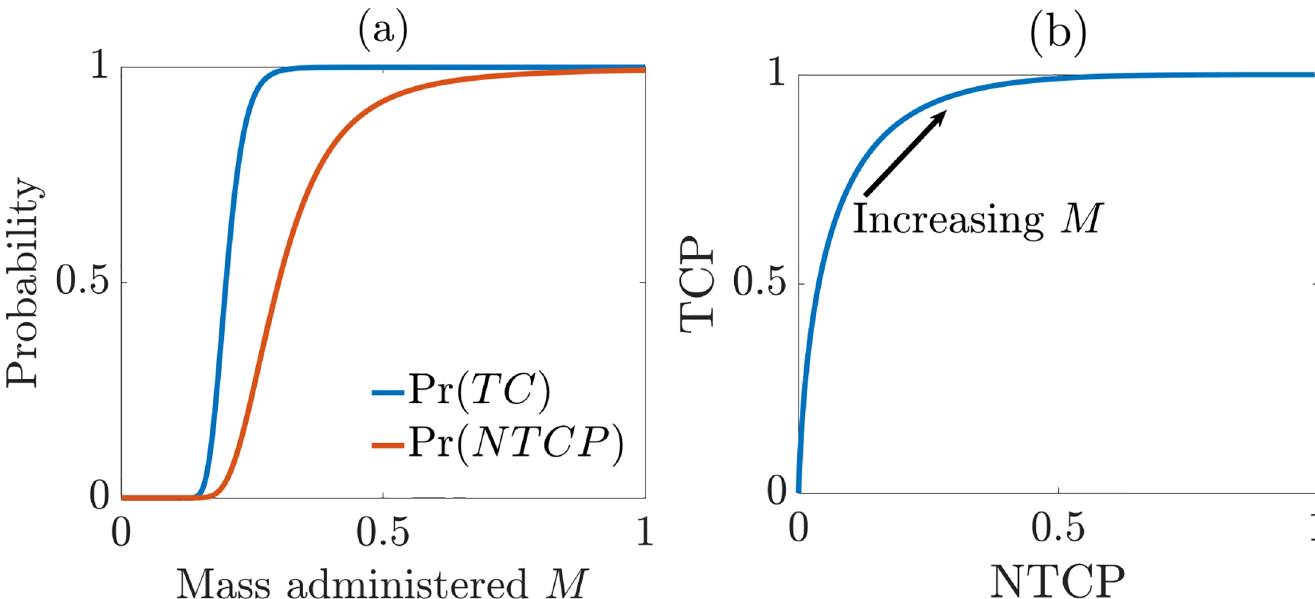
Fig 6. TOC curves. An illustration of a Therapy Operating Characteristic (TOC) curve. (a) Schematic plot of Tumor-Control Probability (TCP) and Normal-Tissue- Complication Probability (NTCP) vs. injected mass of drug, M (arbitrary units); (b) The TOC curve: Plot of TCP vs. NTCP as M is varied.